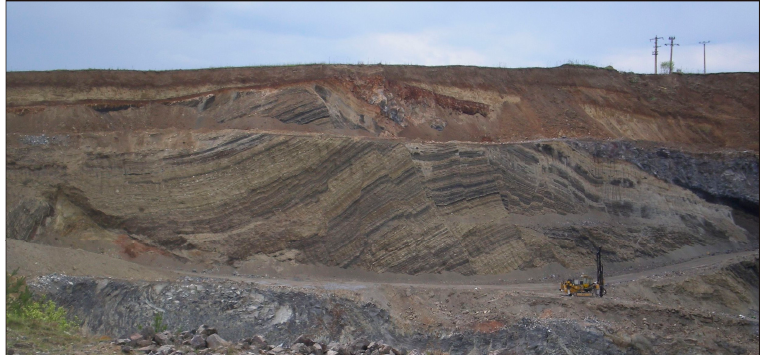
Figure 27. Spectacular outcrop of deformed and faulted phreatomagmatic deposits located in the “Raco ș ul de Jos geologic complex” between the “Raco ș basalt columns”, below, and the eviscerated Heghie ș scoria cone (Figure 21), above (Photo: Alexandru Szakács).